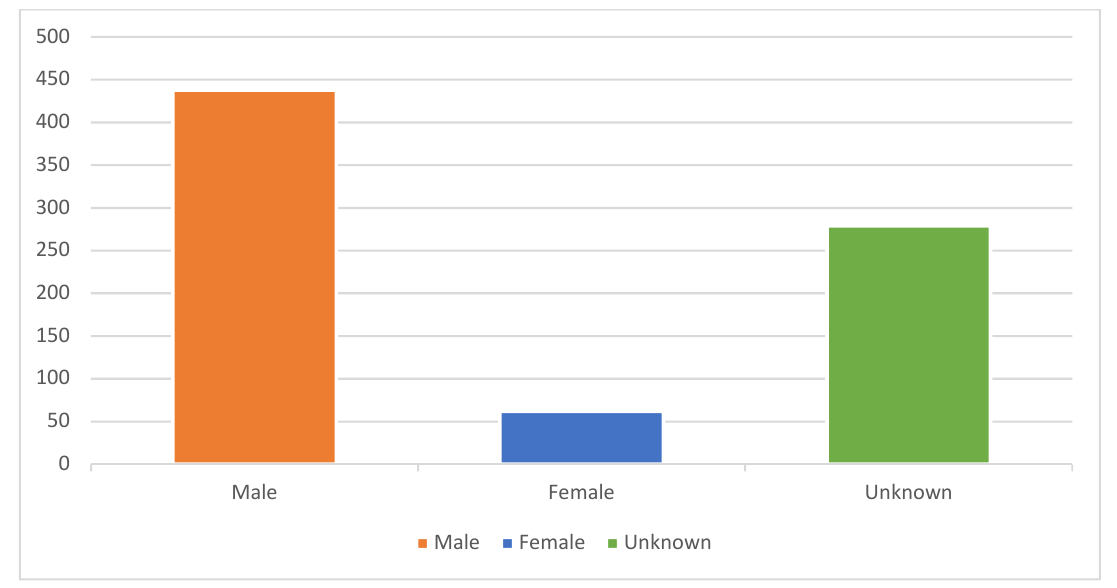
Figure 2. Inferred sex of tweeter.